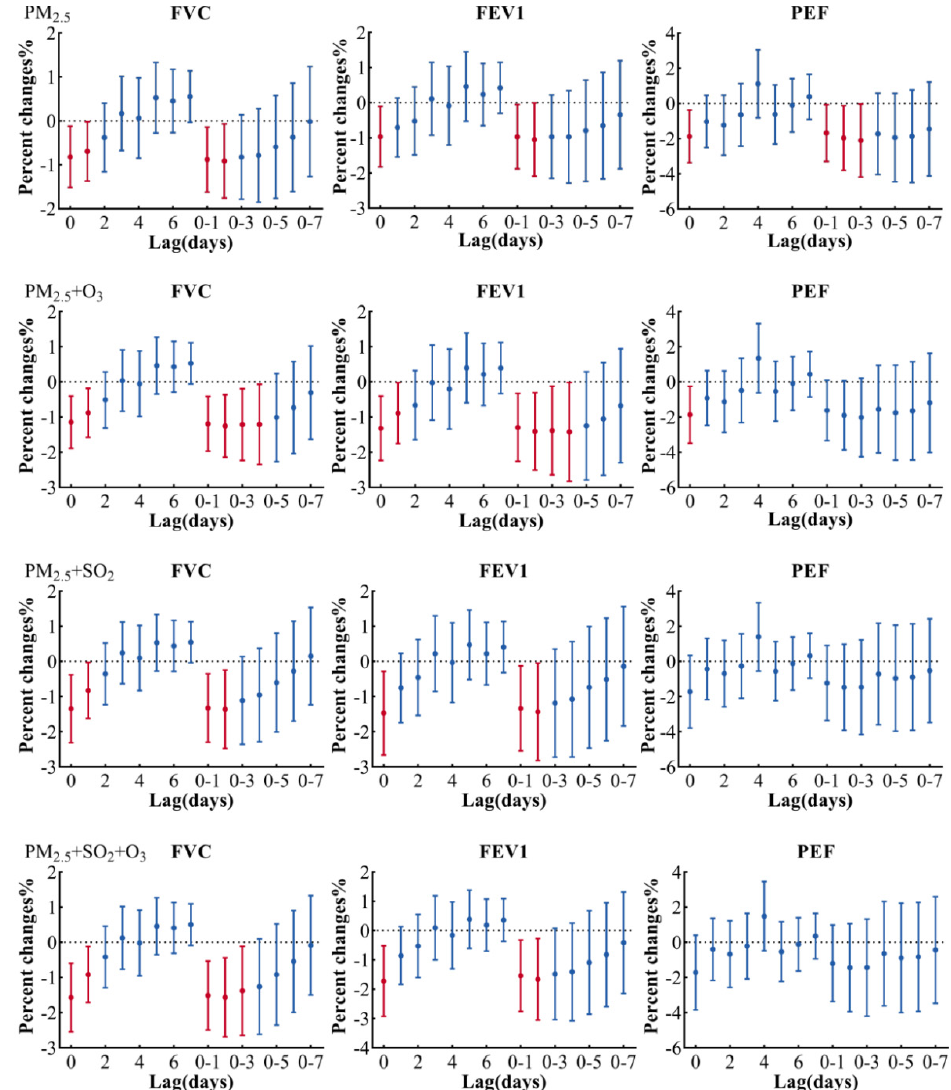
Figure 3. Association between lung function and air pollutants in single- or multi-pollution models. Estimates are adjusted for questionnaire information, relative humidity, temperature, age, BMI, sex, holiday, day of week and times of the measurement. PM 2.5 , fine particulate matter with aerodynamic diameter ≤ 2.5 µ m; O 3 , ozone; SO 2 , sulfur dioxide; FVC, forced vital capacity; FEV1, forced expiratory volume in 1 s; PEF, peak expiratory flow.